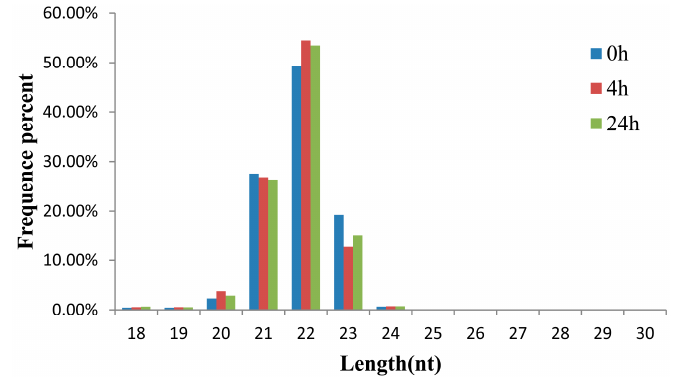
Figure 1. Length distribution of small RNAs in the liver of M. amblycephala at various time points post-infection with A. hydrophila .